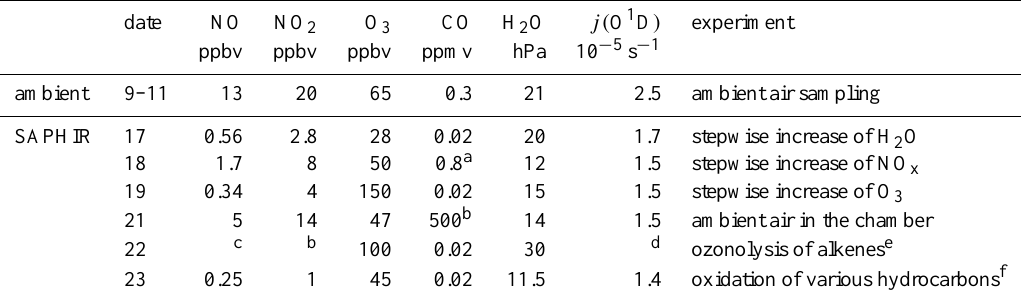
Table 2. Chemical conditions during the experiments of the HOxComp campaign. SAPHIR experiments on 17–19 and 22–23 July were performed in zero air with added reactants. All mixing ratios are maximum values reached during the experiments.